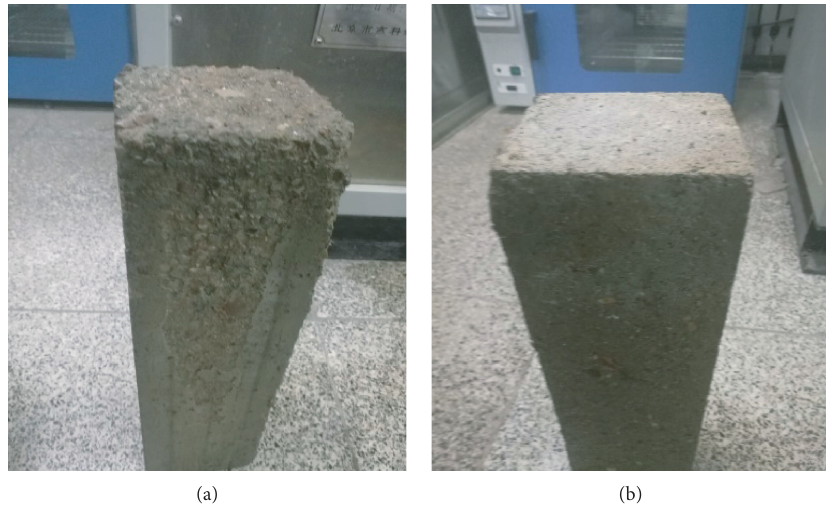
Figure 6: Appearance of C50 concrete after 250 freeze-thaw cycles. (a) B1. (b) B3.